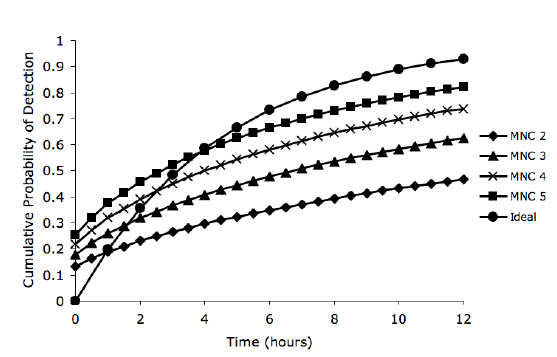
Fig.13. Average CPD of Initial USDEA Cluster Fields Communications Range = 11 kyd